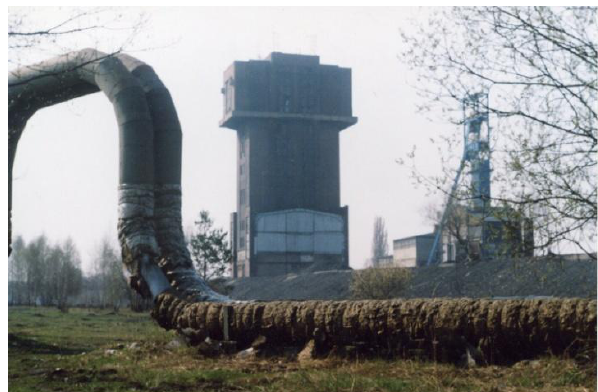
Fig. 4. Historic baths in “Concordia Coal Mine” in Zabrze ( M. Lamparska